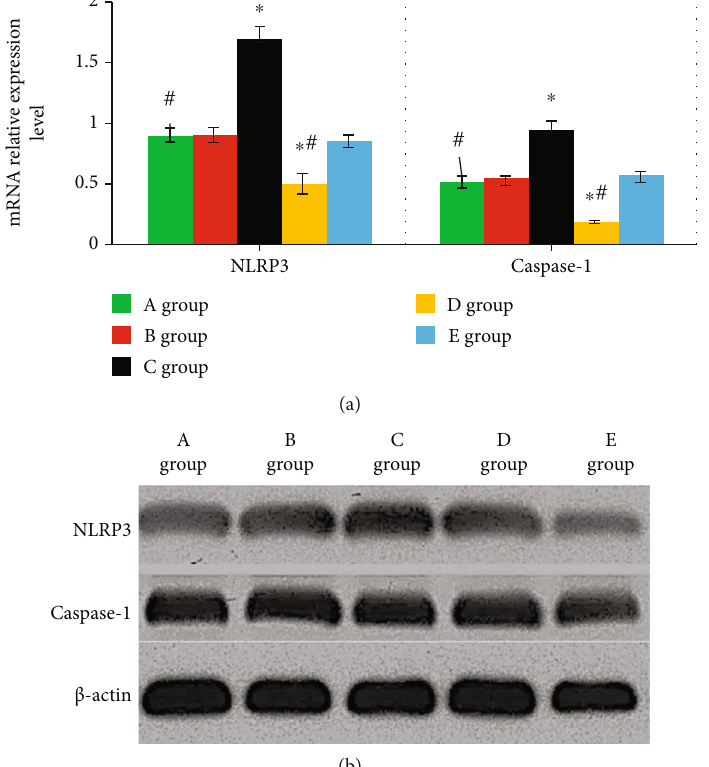
Figure 6: Levels of NLRP3 and caspase-1 proteins. (a) The protein expression level of NLRP3 and caspase-1. (b) The protein band of NLRP3 and caspase-1. ∗ indicated that the comparison with group A showed P < 0 : 05 . # indicated the comparison with group C showed P < 0 : 05 . Among the above items, group A was the blank group, group B was the negative group, group C was the miR-22 mimics group, group D was the miR-22 inhibitor group, and group E was the miR-22 inhibitor+siNLRP3